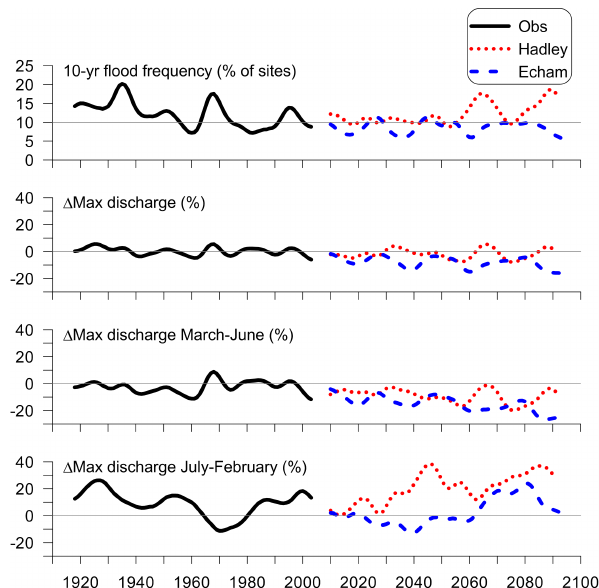
Figure 7. Merged time series of deviations (%) versus the mean for the reference period shown for actual observations (1910–2010) and modeling results (2010–2100) for past and future annual maximum high flows in Sweden. The lines represent a 10-year Gauss filter for observations (Obs) and S-HYPE forced with climate projections (Hadley and Echam). Figure 8. Annual distribution of daily high flow (Jan–Dec) in se-